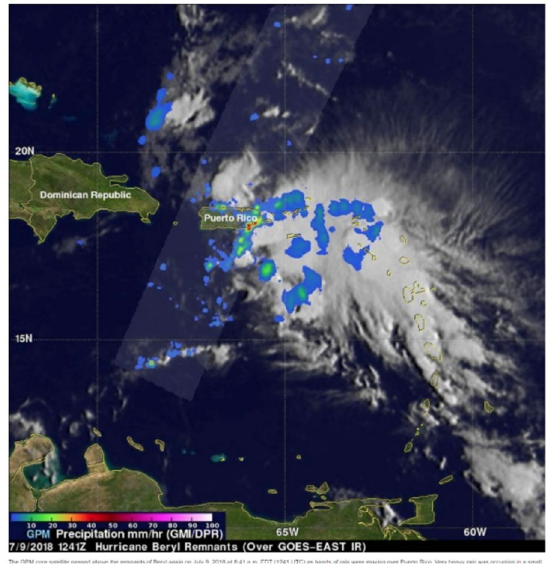
Figure 4. Tropical Storm Beryl over Puerto Rico [28].